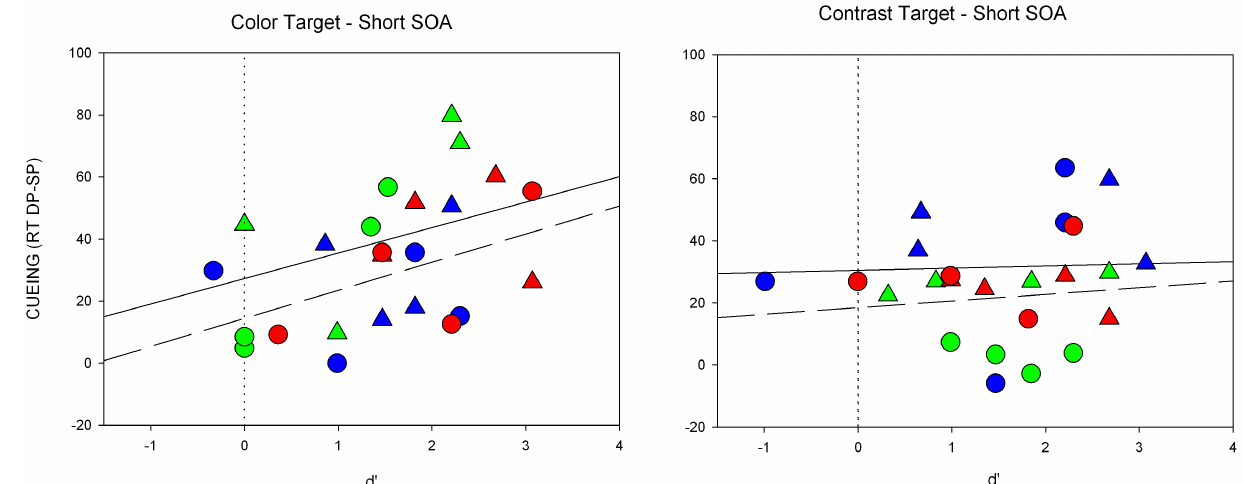
Figure A1. Individual scatter plots for Experiment 1. Shown are RT differences ( y -axis) and the respective d’ -value ( x -axis) for each participant separately. Panels depict results of the short SOA (cueing effects, i.e. , mean RTs for DP minus RTs for SP condition). Values are plotted separately for same contrast/color conditions (triangles, solid regression line) and different color/contrast conditions (circles, dashed regression line). For color targets (panel on the left side), the symbols are plotted in the corresponding target color, for contrast targets (panel on the right side) the color of the symbols correspond to the cue color.